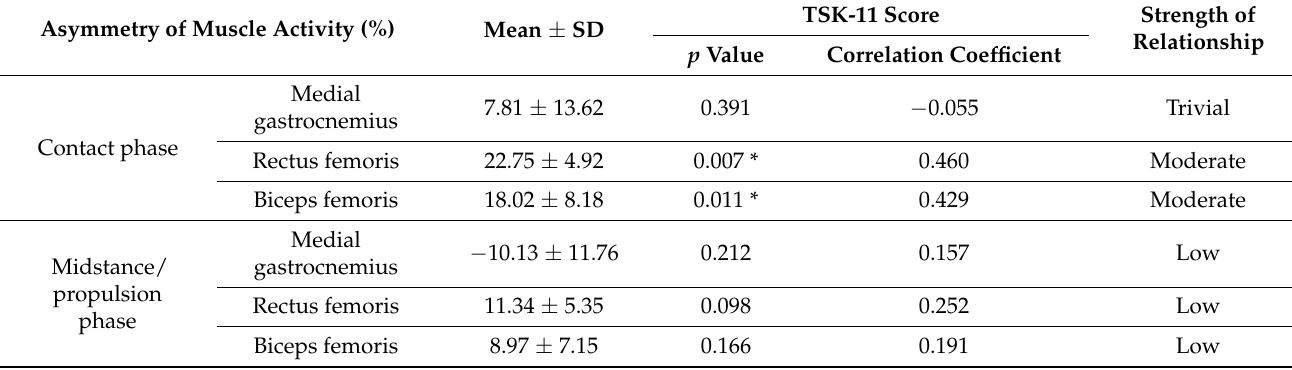
Table 3. Correlations between TSK-11 scores and asymmetry of muscle activity during gait. Asymmetry of Muscle Activity